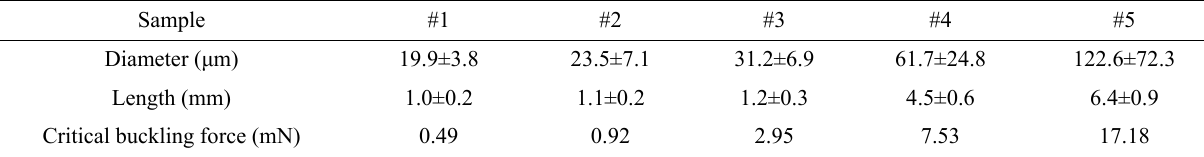
Table 3 Average diameters, lengths, and critical buckling forces of